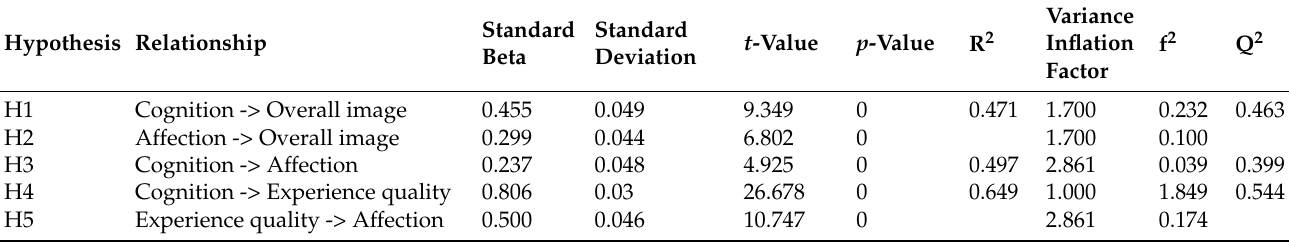
Table 10. Assessment of structural model.